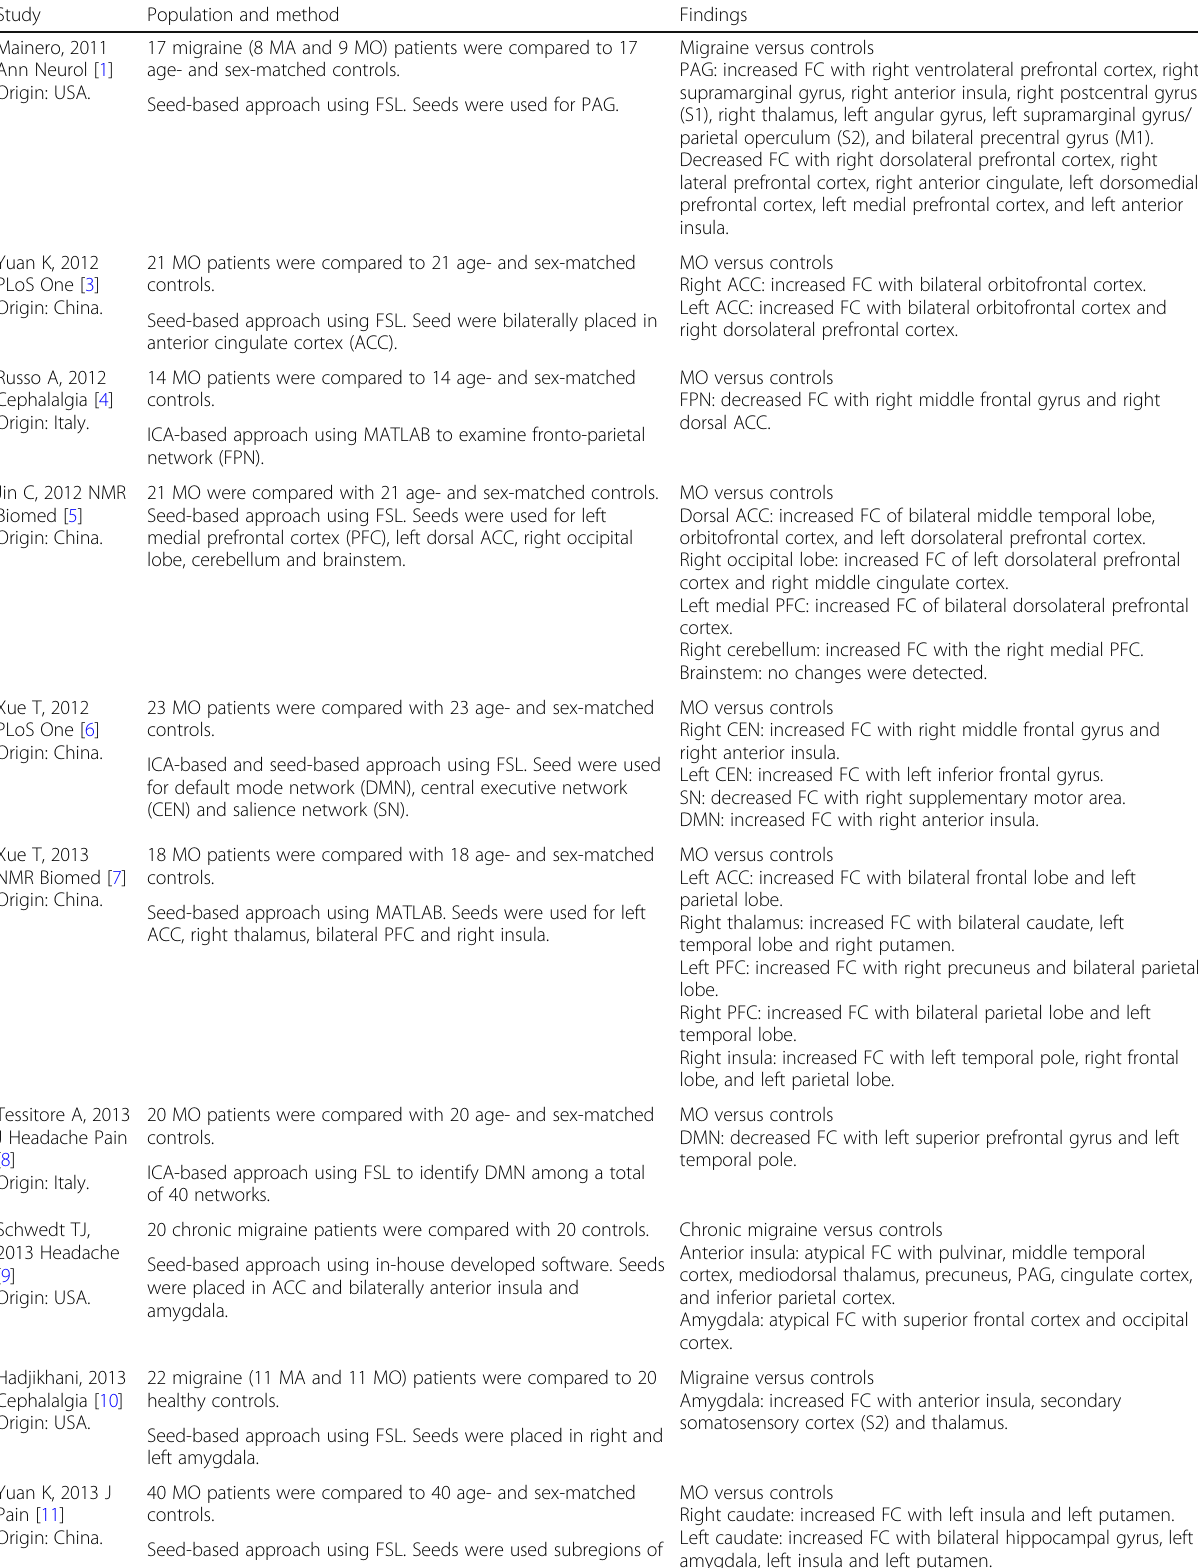
Table 1 Functional connectivity MRI during the interictal phase of migraine compared with non-migraine controls Study Population and method Findings